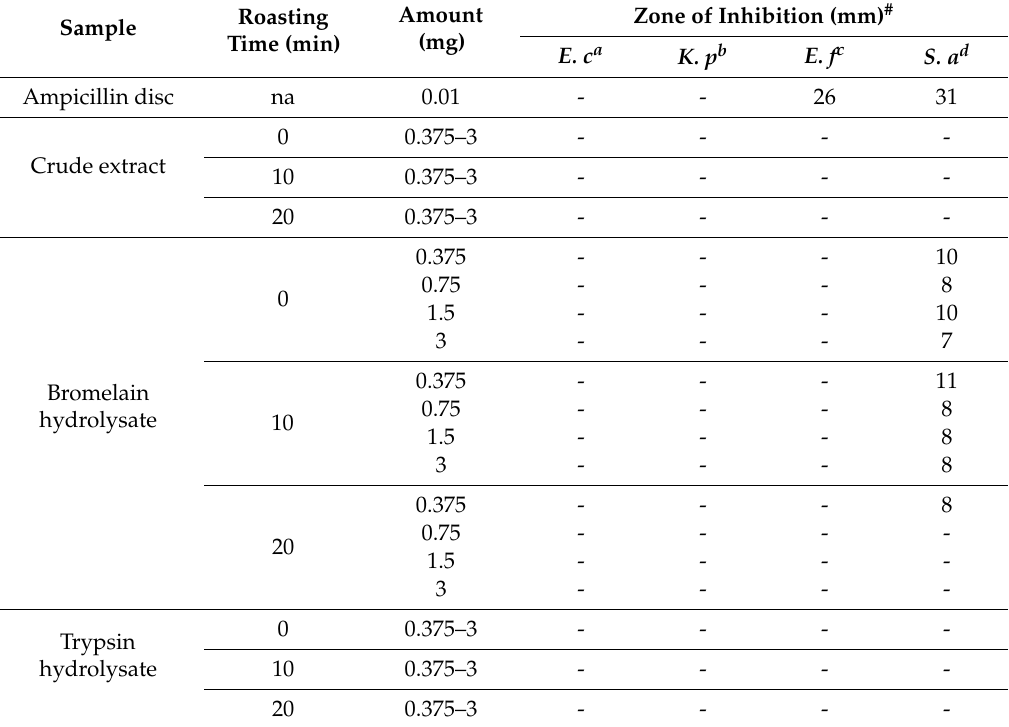
Table 1. Zone of inhibition of ampicillin disc, crude extracts, and hydrolysates of raw and roasted seeds.